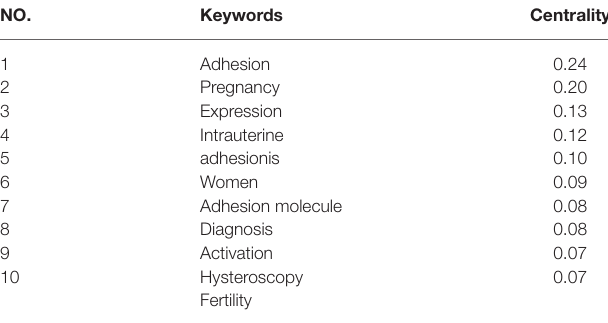
TABLE 4 | The top 10 keywords sorted by centrality. NO.